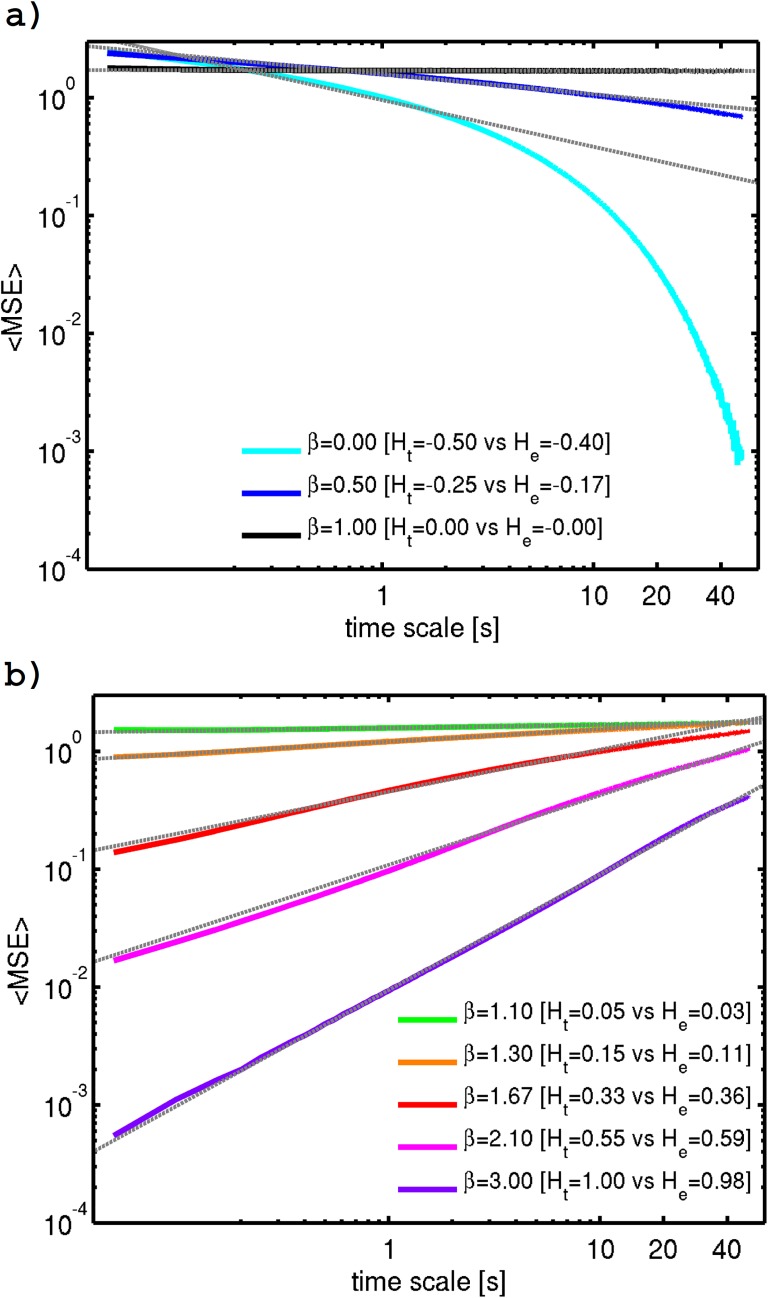
Ensemble MSE averaged over the 60 SF realizations for each of the considered β values.a) β values of 0, 0.5 and 1.0; and b) β values of 1.1, 1.3, 5/3, 2.1, and 3.0. The corresponding H values–theoretical (from Eq 4) and empirical (estimated by linear regression, with the fits shown by gray dashed lines) are detailed in the legend. Here the ensemble average is taken over the 60 SF realizations for each of the considered β.